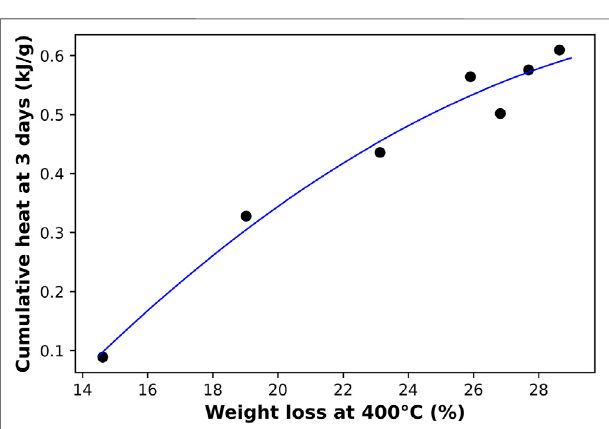
FIGURE 9 | A correlation between the weight loss percentage acquired from TGA tests at 400 ° C on 3 month old AAM samples and the cumulative heat obtained by isothermal calorimetry after 3 days of reaction. Each data point represents a different Na/Al ratio (0.6 – 1.8).